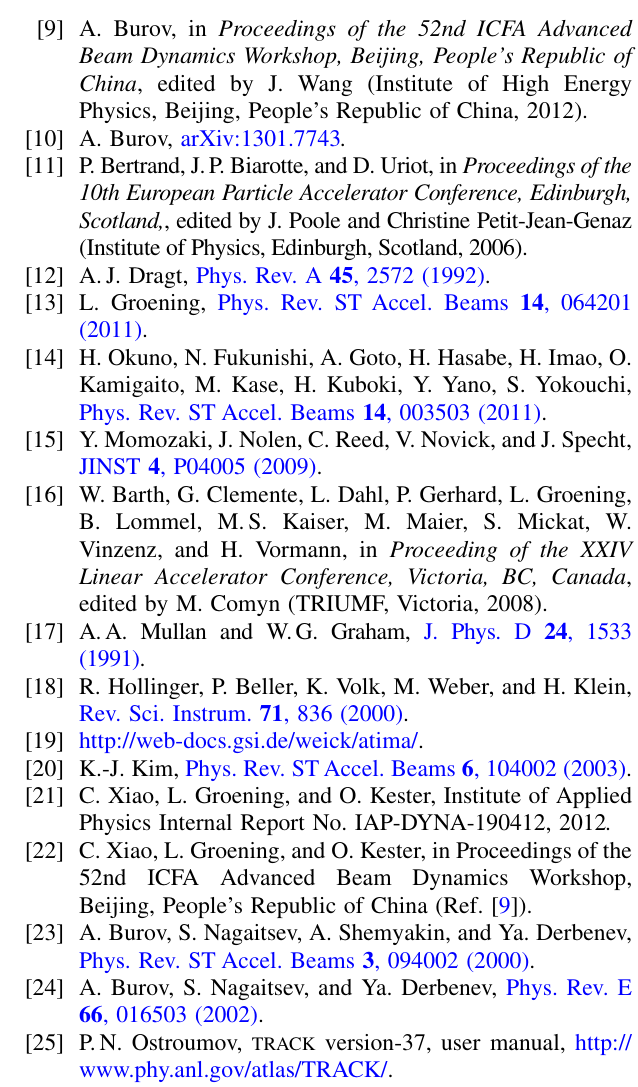
sumed for the tracking